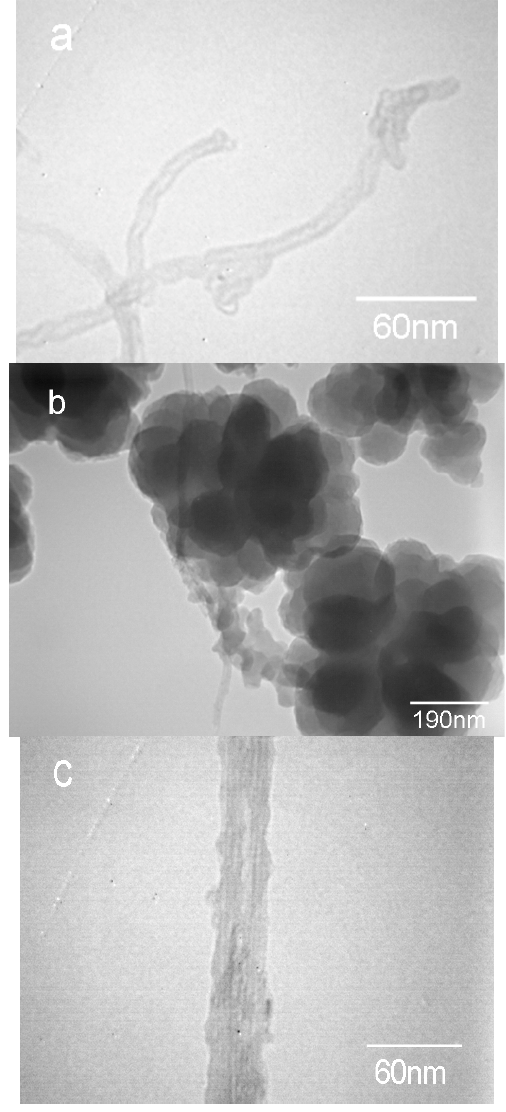
Figure 1. TEM images of ( a ) amino-CNTs, ( b , c ) amino-CNT/PAN microspheres with different magnifications, TEM: transmission electron microscopy; CNT: carbon nanotube; PAN: polyacrylonitrile.